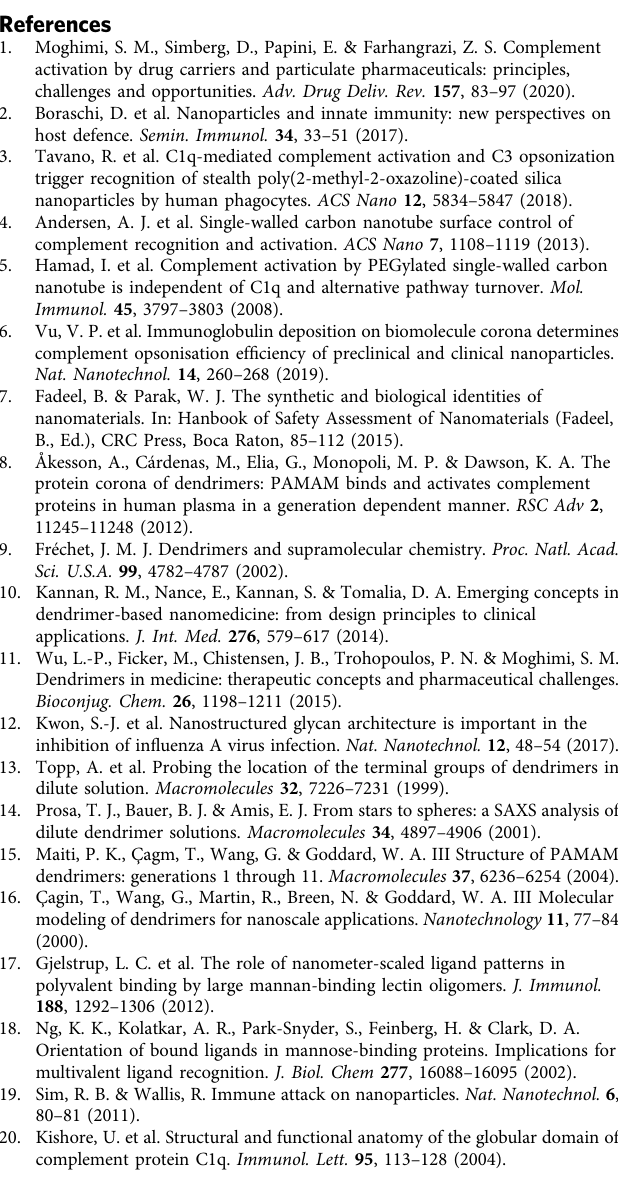
Table 1), Fourier transform infrared spectra (Supplementary Figs. 21 – 23; Supplementary Table 1), UV/Vis and fl uorescence spectra (Supplementary Fig. 24; Supplementary Table 1), size exclusion chromatography-multi angular light scattering chromatogram (Supplementary Figs. 25 – 27; Supplementary Table 1), and mass spectra (Supplementary Methods; Supple- mentary Table 1) are reported in Supplementary Information fi le. Raw data for Fig. 1c is included in the Supplementary Table 1 in Supplementary Information fi le. No raw data is associated with Figs. 1a, b and 4. Remaining raw data supporting the fi ndings of this study are available from the corresponding author upon reasonable request. Source data are